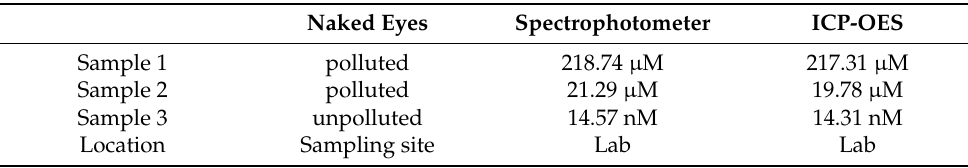
Table 1. Comparison of actual sample results by different methods.